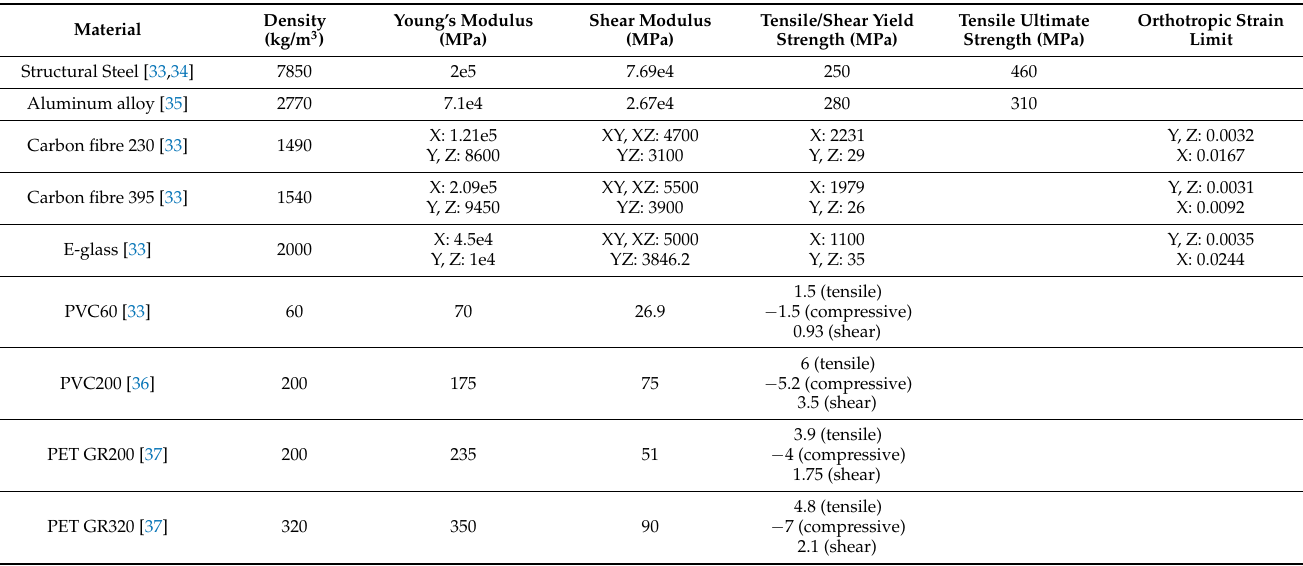
Table 3. Properties of materials used in the parametrization of structural candidates.